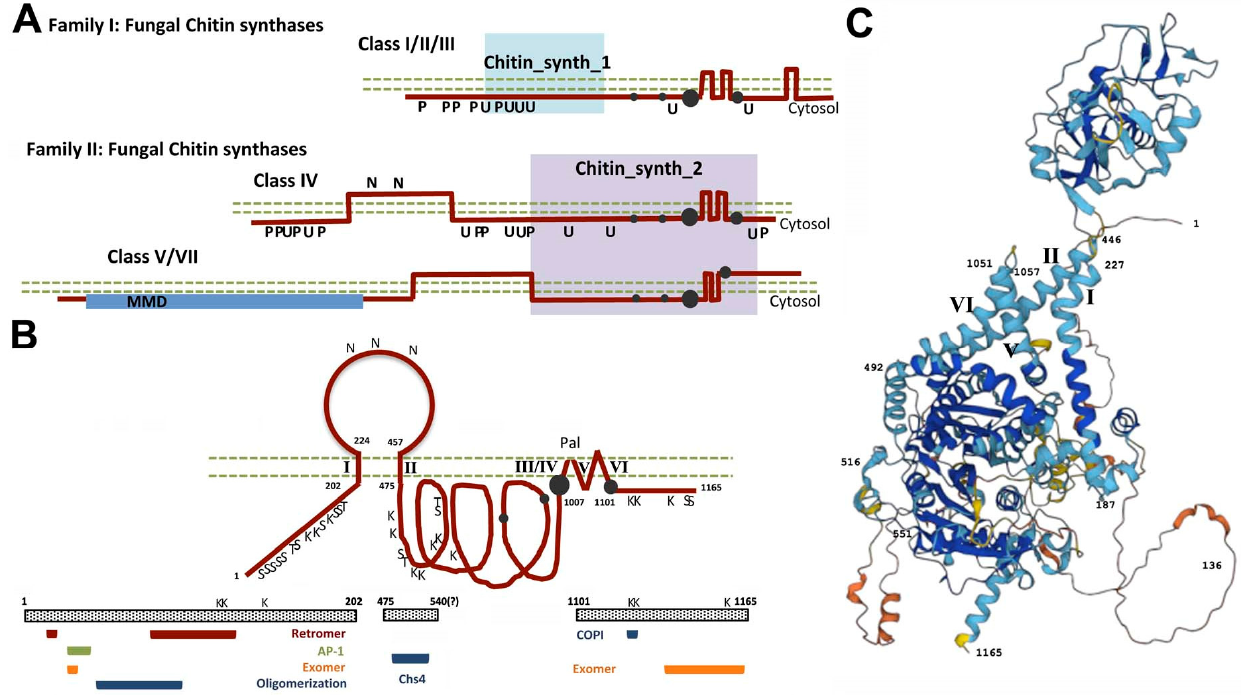
Figure 1. Structure of the chitin synthase (Chs) proteins. ( A ) Classification of the different Chs proteins based on their amino acid sequences and predicted secondary structures. Note that these proteins are expected to be type II integral transmembrane proteins. The different domains of each protein are indicated together with the conserved catalytic regions (gray dots). Posttranslational modifications are indicated based on the high-throughput analysis performed for the Saccharomyces cerevisiae proteome. Phosphorylation (P), ubiquitination (U), and N -glycosylation (N) are noted. ( B ) Detailed structure of the S. cerevisiae Chs3 protein with its three cytosolic domains and a luminal region that is N -glycosylated. The transmembrane domains are depicted with their predicted architecture, including the proposed site for palmitoylation (Pal). All the phosphorylation (S/T) and ubiquitination (K) sites that were experimentally verified are indicated. The lower part of the figure shows all the protein regions that were shown to be required for interaction with the indicated complexes or proteins. Note that most of them are located at the N-terminal cytosolic region of the protein, which serves as a major platform mediating protein interactions. ( C )The predicted Al- phaFold model structure for Chs3. This model confirms the proposed structure with a luminal re- gion (upper part) and three cytosolic regions with some domains highly exposed and thus suscep-